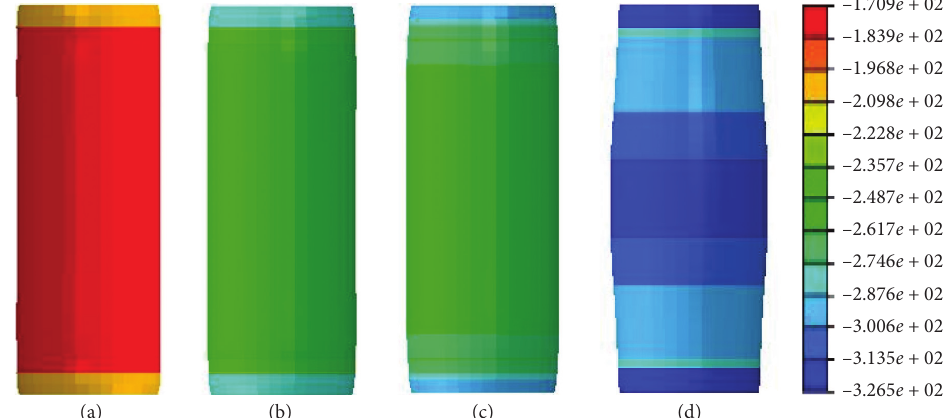
Figure 7: The longitudinal stress contour maps of the stainless steel tube. (a) Point A. (b) Point B. (c) Point C. (d) Point D.